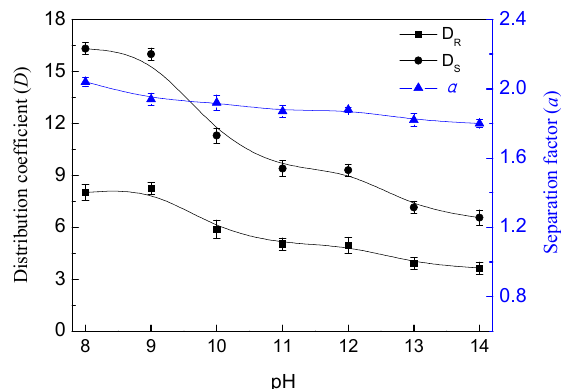
Figure 7. Effect of system pH on the chiral extraction of phenylalanine enantiomers. The extraction conditions were as follows: 30 wt% [Ch][L-Pro], 7.8 wt% K 3 PO 4 , 40 mmol/L HP- β -CD, 15 mg/mL phenylalanine. The extraction experiments were done at room temperature.